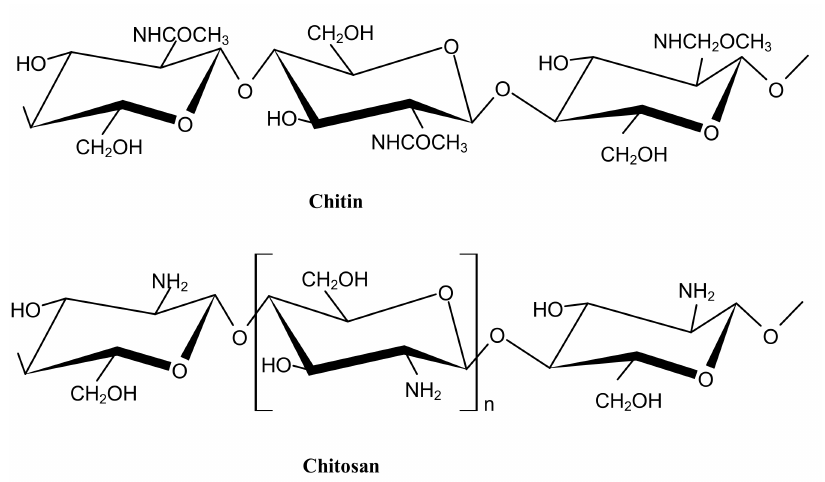
Figure 1. Chemical structure of chitin and chitosan. Reprinted from Vo et al. [1] with permission from John Wiley and Sons and Copyright Clearance